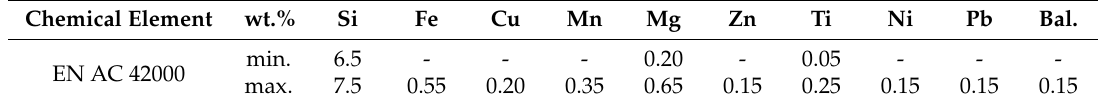
Table 1. Chemical composition of AlSi7Mg alloy [35].